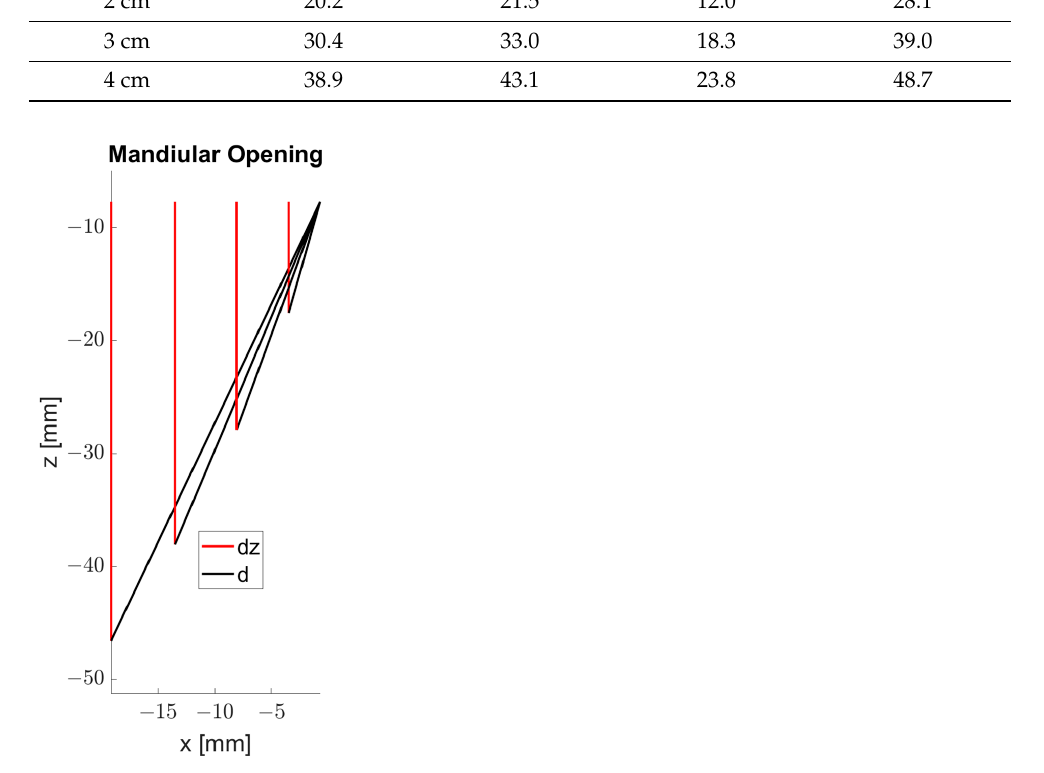
Figure 6. Parameters Euclidean distance (d), and vertical range (dz).